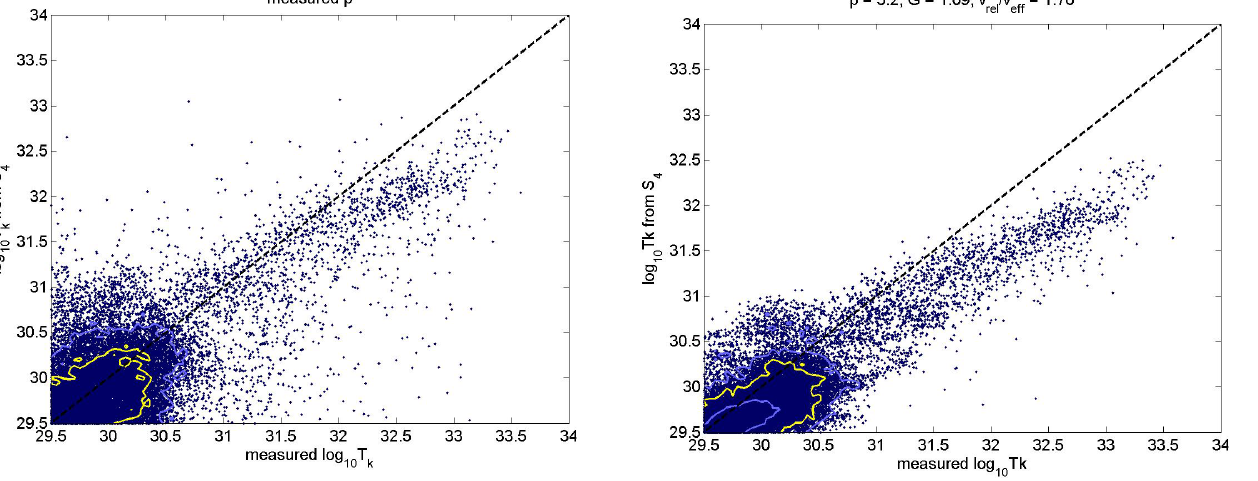
Fig. 9. log 10 T k estimated from S 4 , compared to the measured val- ues.